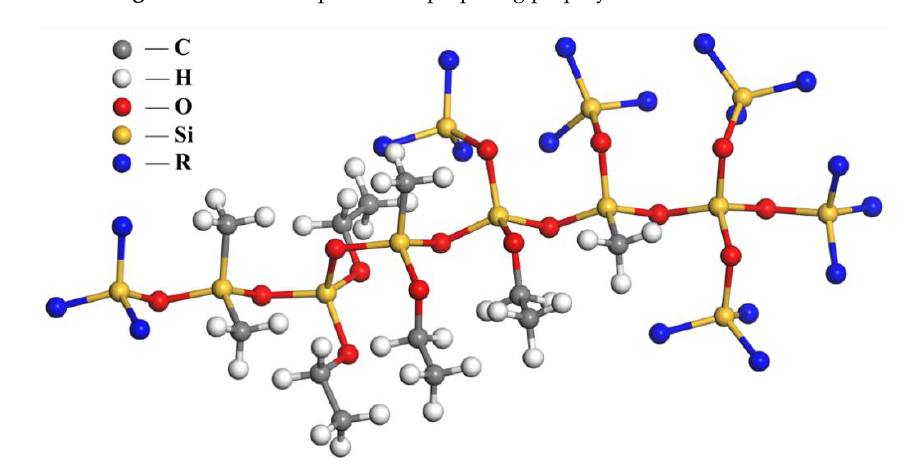
Figure 2. Structure of solidified silicone resin.